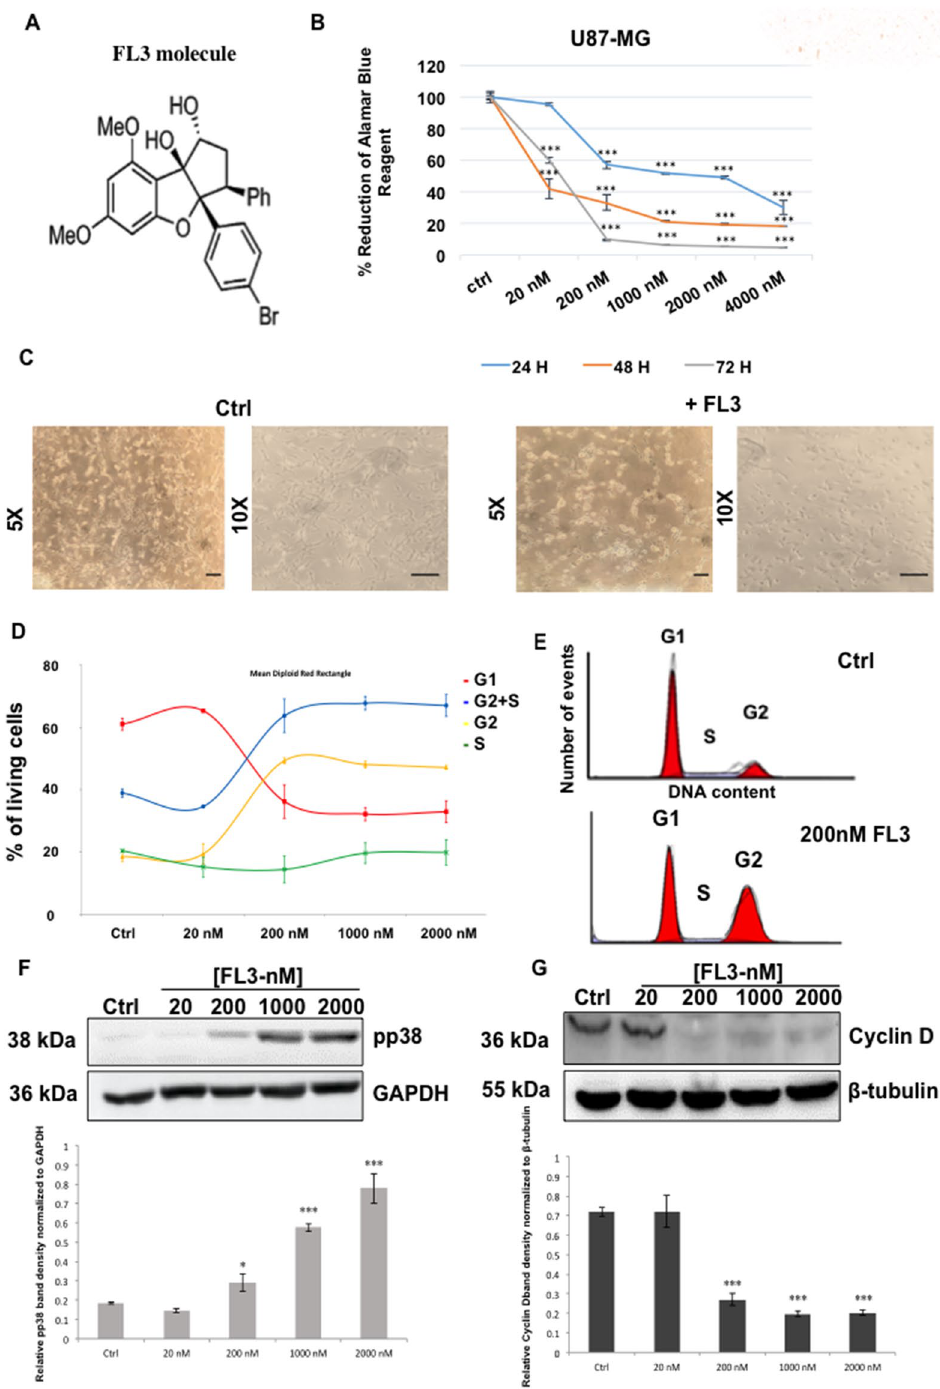
Figure 1. Effect of FL3 on U87-MG glioblastoma cancer cells metabolic activity and proliferation. ( A ) Chemical structure of FL3. ( B ) Analysis of cell viability with the AlamarBlue assay at different time points in U87-MG control cells and U87-MG treated cells with different concentrations of FL3. ( C ) Representative images of control cells and U87-MG cells treated with 200 nM FL3. The scale bar represents 200 μm. ( D ) Distribution of cells in each cell cycle phase in control and treated conditions. ( E ) Representative histogram of cell cycle analysis of U87-MG cells treated with 200 nM FL3. ( F ) Western Blot and quantification of pp38 protein expression in control cells and U87-MG cells treated with different concentrations of FL3. ( G ) Western Blot and quantification of Cyclin D protein expression in control cells and U87-MG cells treated with different concentrations of FL3. Quantification of mean ± SEM from 3 independent experiments, *P < 0.05, **P < 0.01, ***P < 0.001 from control. n = 3 for each